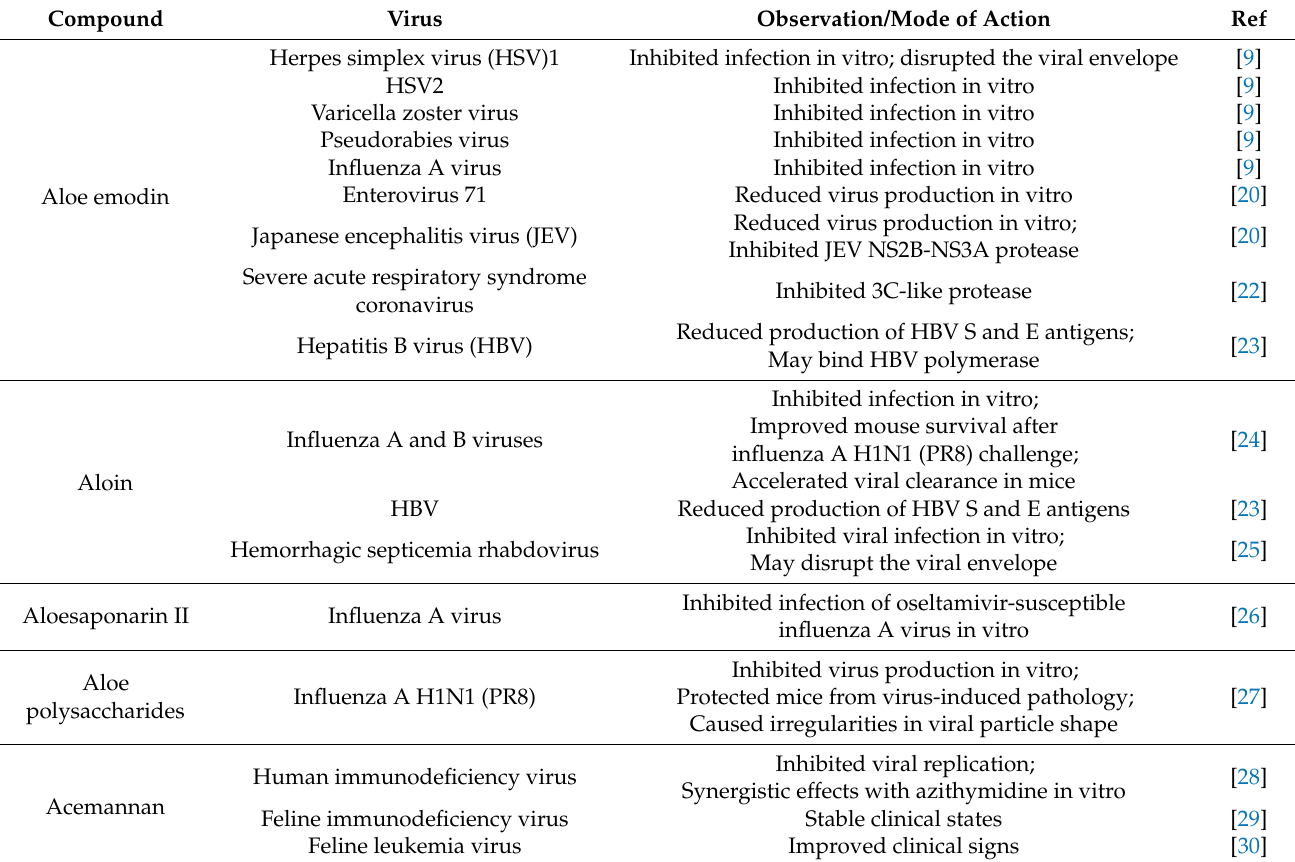
Table 2. Aloe vera compounds with antiviral